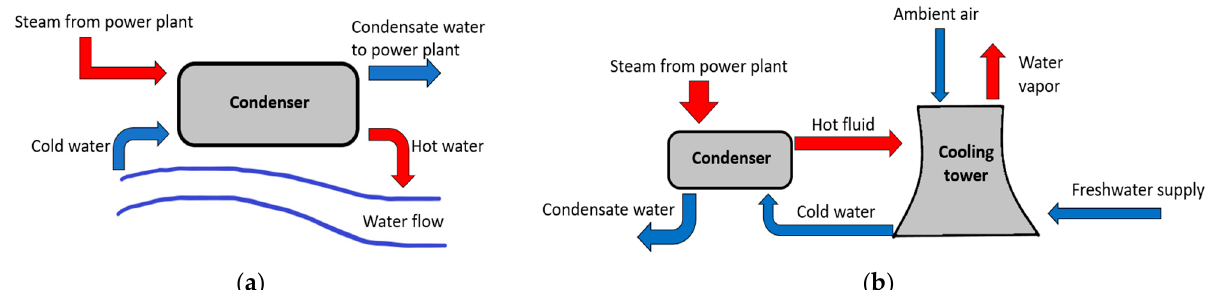
Figure 1. Cooling system technology of power plants: ( a ) the once-through cooling system, ( b ) the recirculating cooling system. Either type of steam cycle can have either type of cooling system. Blue arrows indicate cold fluid flow and red hot/warm fluid flow.